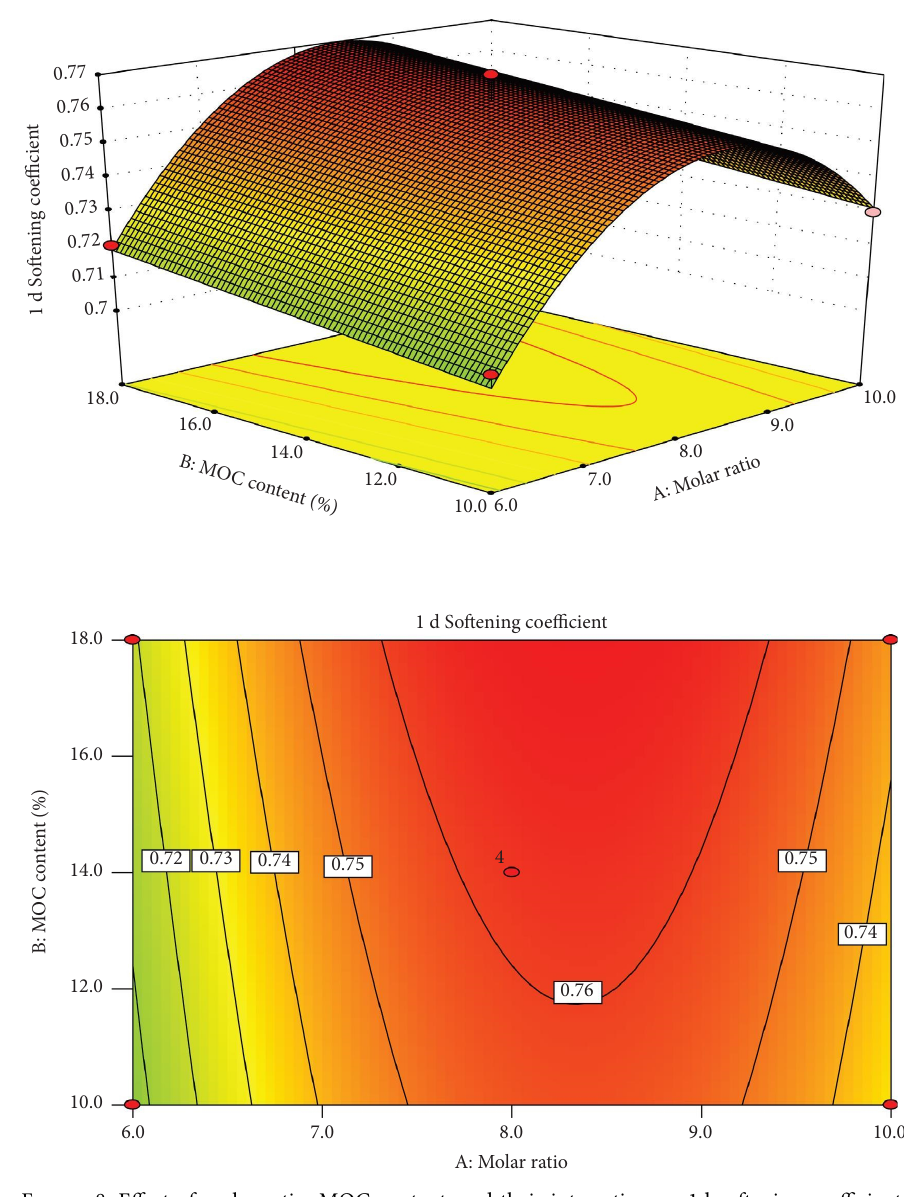
Figure 8: Efect of molar ratio, MOC content, and their interaction on 1d softening